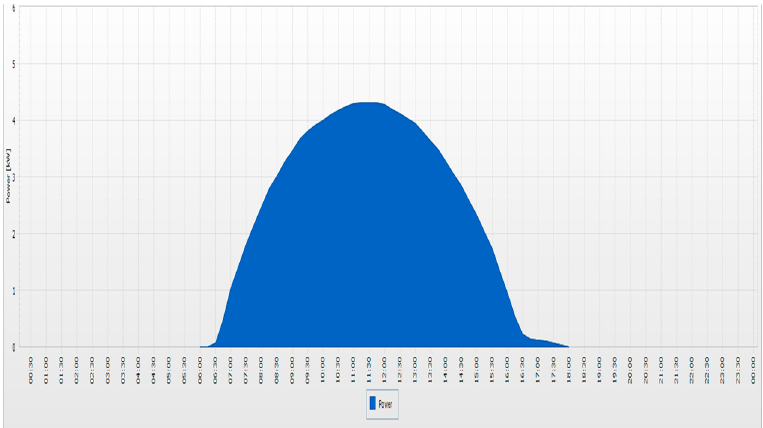
Figure 9. A chart indicating the solar efficiency of the above house on a sunny day (15 March 2020). Location: 49°57 ′ N, 19°55 ′ E (source: sunnyportal.com).